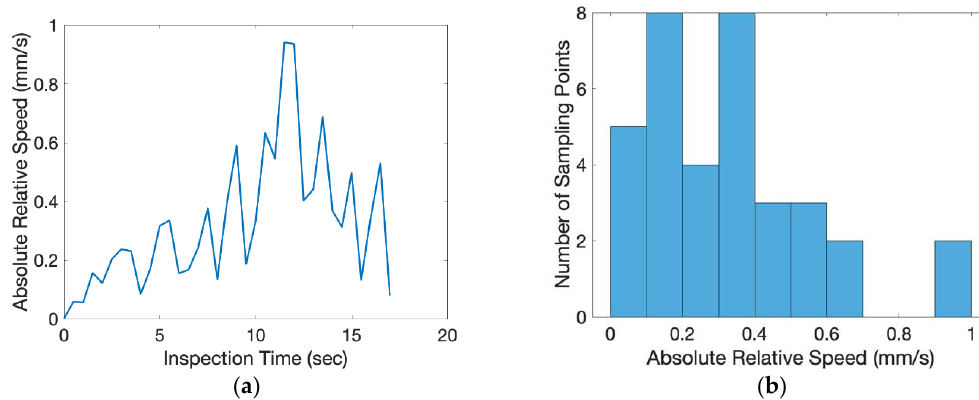
Figure 12. The absolute relative speed of the center of the circular mark between each consecutive inspection image: ( a ) analysis with respect to time, ( b ) histogram of analysis.